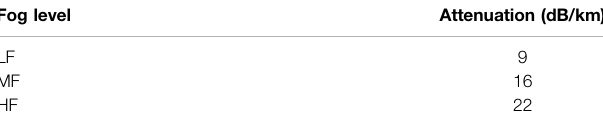
TABLE 3 | Fog level with attenuation